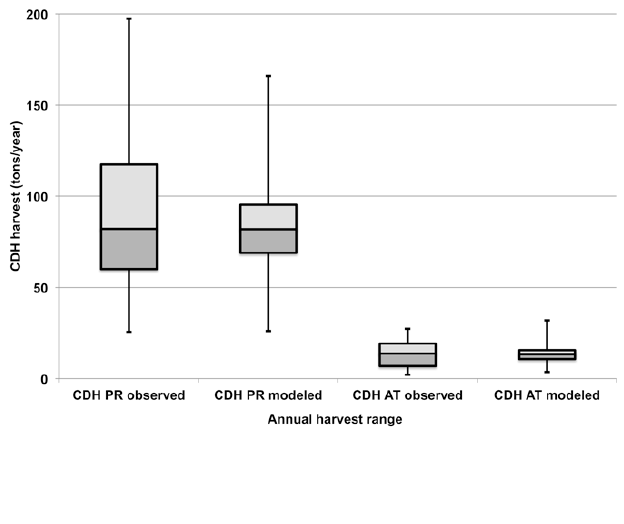
Fig. 4 . Validation of the pen shell harvest in tons per year. Pr refers to Pinna rugosa , At refers to Atrina tuberculosa , and CDH refers to Callos de Hacha, or the entire pen shell population. The two box plots on the left show the maximum, 75th percentile, median, 25th percentile, and minimum harvest values (excluding outliers) as extrapolated from the observed harvest data. The box plots at right show the distribution for harvest tonnage as calculated by the model over a 100-year period under conditions similar to experiment #8 (the experiment with the most realistic base conditions).